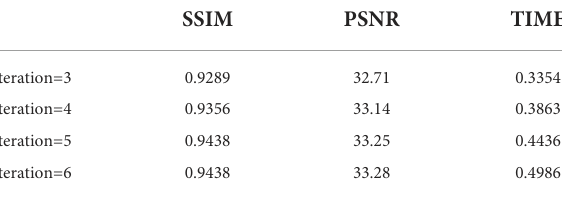
TABLE 3 Use outdoor synthetic images to test models with different iteration times, use PSNR, SSIM, and TIME for